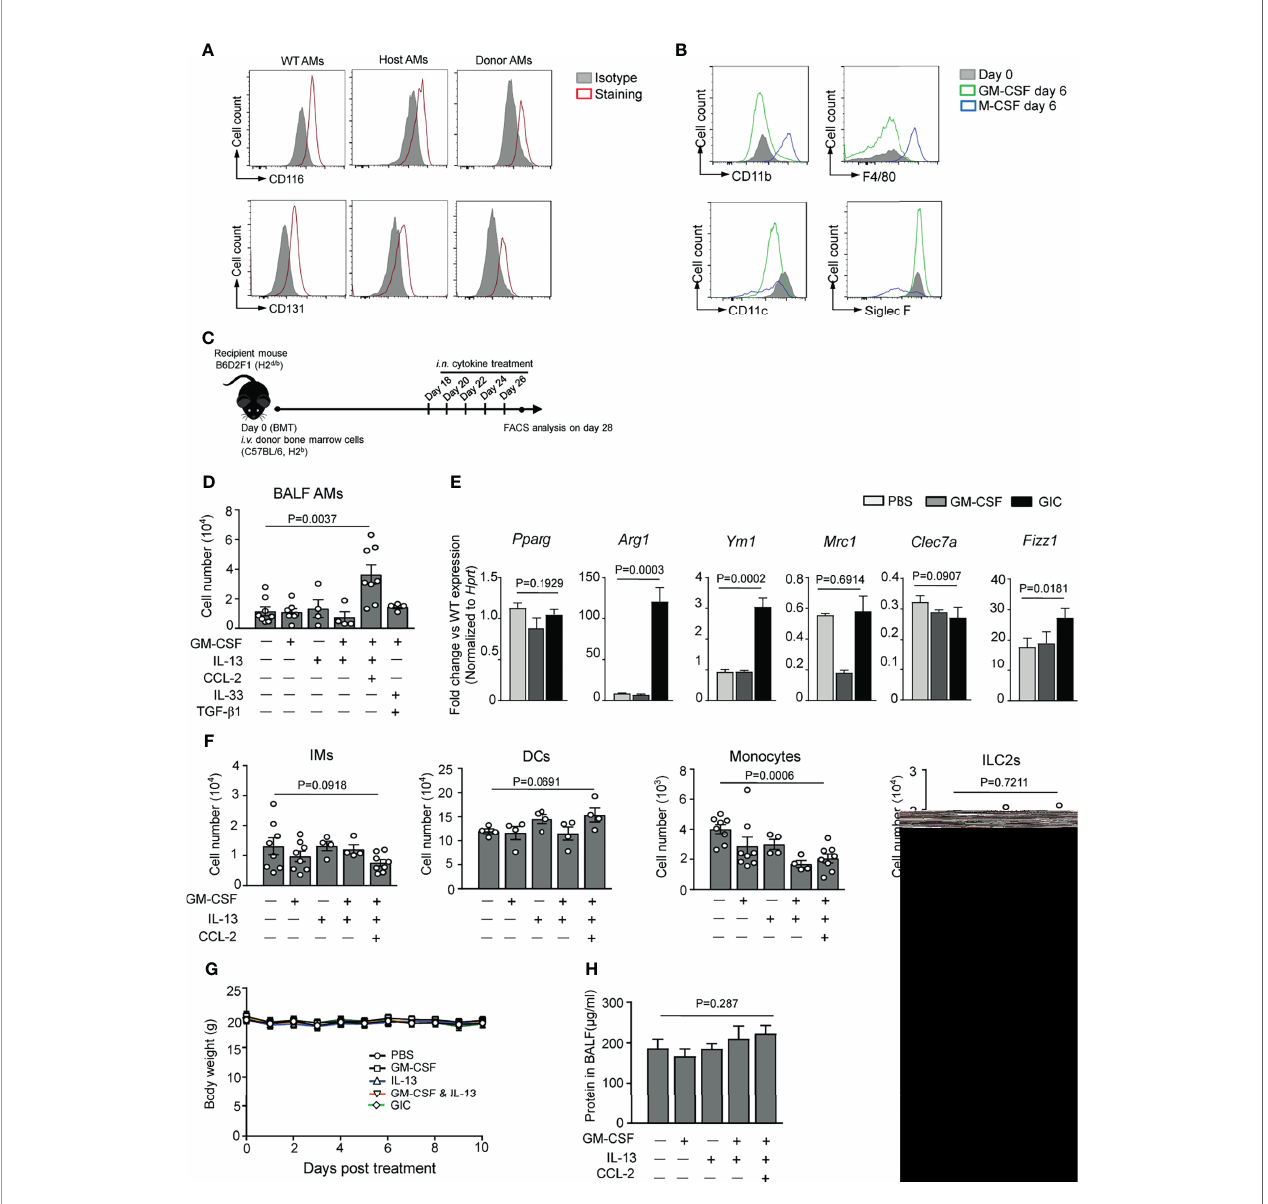
FIGURE 3 | In vivo cytokine administration promotes AM reconstitution after TCD-BMT. (A) CD116 and CD131 expressions on host- and donor-derived AMs from day 14 and day 42 allogeneic recipient mice with TCD-BM grafts, respectively, were analyzed by fl ow cytometry analysis. BAL AMs from WT C57BL/6 mice were used as control. AMs from three mice in each group were equally pooled, and the expression of cell surface receptors was analyzed. (B) BAL AMs from WT C57BL/ 6 mice were cultured in vitro in the presence of 30 ng/ml of recombinant M-CSF or 30 ng/ml of recombinant GM-CSF for 6 days. Then cells were harvested, and cell surface expression of CD11b, F4/80, CD11c, and Siglec F was analyzed by fl ow cytometry. Freshly isolated WT AMs were used as control. (C) A schematic of i.n. cytokine treatment strategy after BMT. TCD-BMT-recipient mice were given different cytokines, alone or combination, started from day 18 every other day for a total of fi ve times. (D) Two days after the last cytokine treatment, BAL AMs were analyzed in allogeneic recipient mice by fl ow cytometry. Data shown are the pooled results of two independent experiments with three to fi ve mice per group in each experiment. (E) Q-PCR analyses of BAL AMs from allogeneic recipient mice treated with different cytokines in vivo . Gene expression was normalized by relative fold change of each gene versus that in AMs from WT mice. Data are represented as mean ± SEM (n = 3). (F) Lung tissue IMs, monocytes, DCs, and ILC2s were analyzed by fl ow cytometry in allogeneic recipient mice 2 days after the last time in vivo cytokine treatment. Data shown are pooled result of two independent experiments with three to fi ve mice per group in each experiment. Data are represented as mean ± SEM. (G) Body weight of mice was monitored after the cytokine administration in different groups. (H) Two days after the last cytokine treatment, total protein concentration in BAL fl uid of allogeneic recipient mice treated with or without cytokines was measured. Data are represented as mean ± SEM (n = 4). AM, alveolar macrophage; TCD, T cell-depleted; BMT, bone marrow transplantation; BAL, bronchoalveolar lavage; WT, wild type; IM, interstitial macrophage; DC, dendritic cell; ILC2, group 2 innate lymphoid